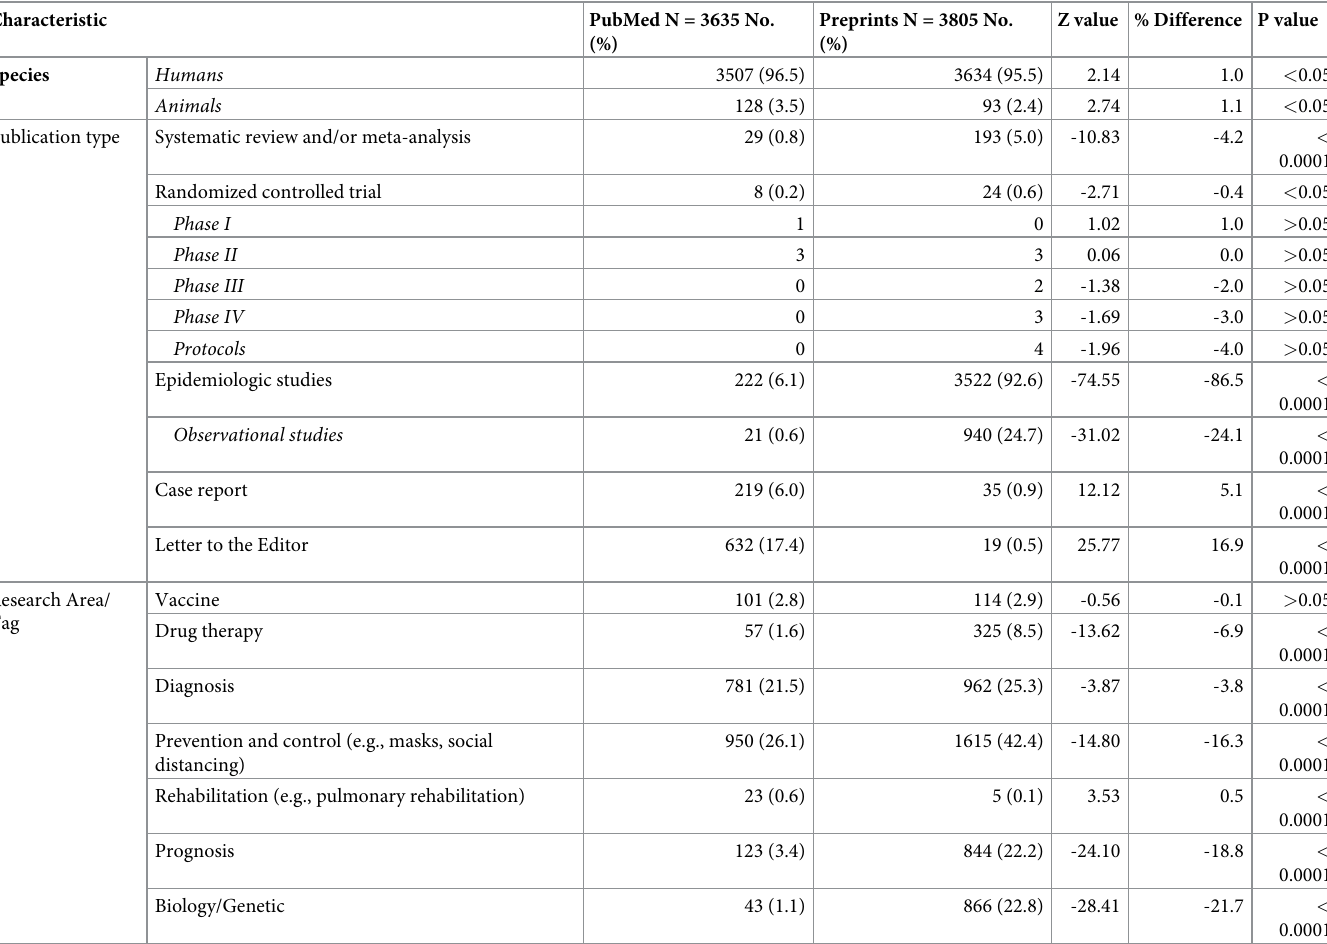
Table 1. Characteristics of COVID-19-related academic (PubMed) and preprint publications.